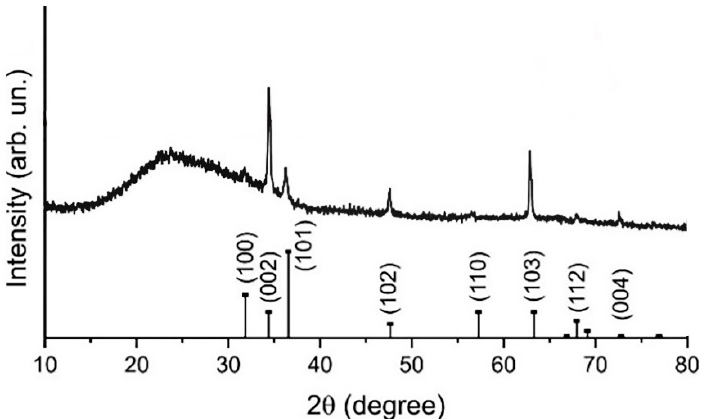
Figure 1. XRD patterns of the ZnO NR array samples synthesized by the CBD method.